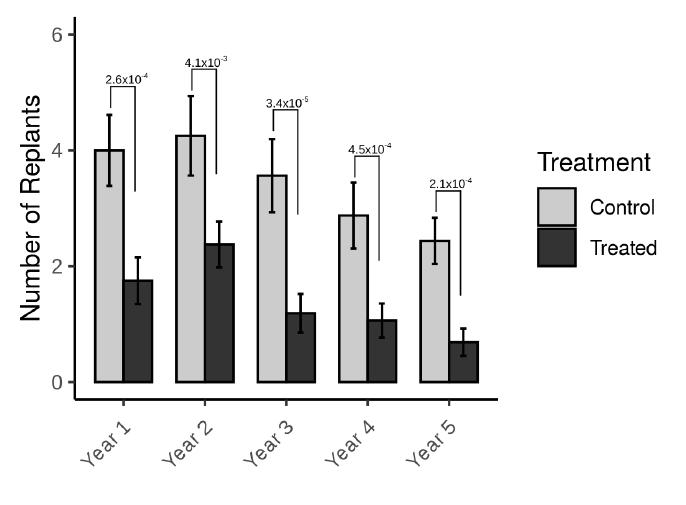
Figure 4. Number of vines replanted per row with 130 vines per row in treated and untreated blocks for five consecutive years following fungicide application. Poisson regression followed by the post-hoc Dunnett test was used to determine statistical di ff erence between treated and untreated vines, and p values are presented above the bars. N = 15